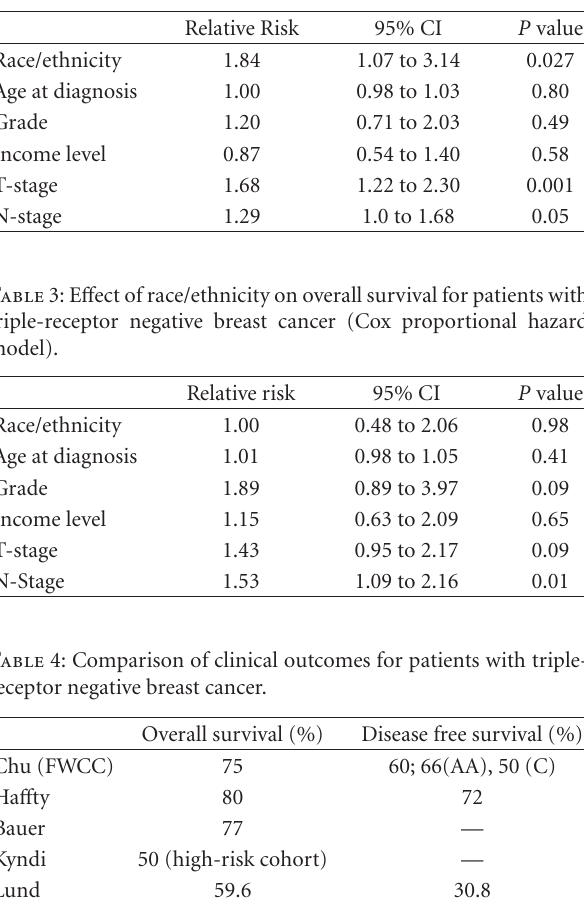
Table 2: E ff ect of race/ethnicity on cancer recurrence for patients with triple-receptor-negative breast cancer (Cox proportional haz- ard model).